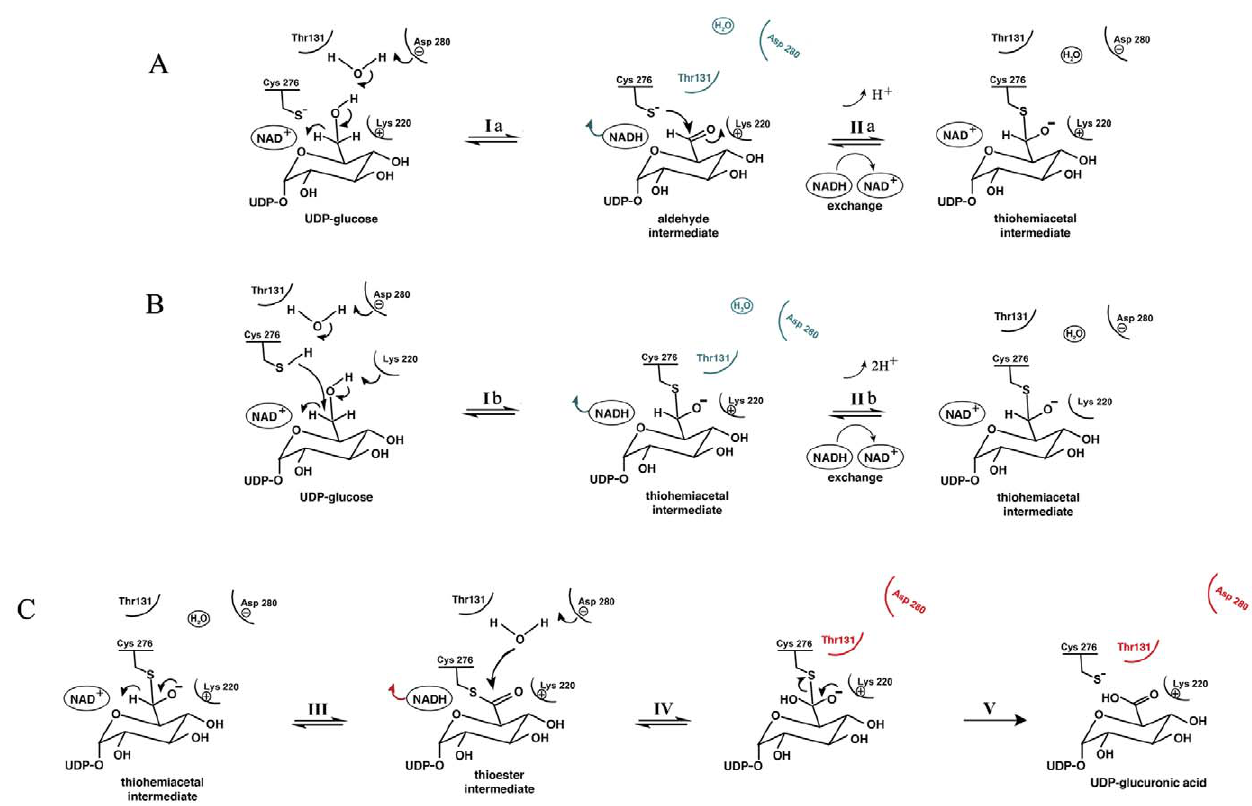
Figure 1. Mechanism of hUGDH catalysis. (A) In the first phase of the mechanism established from the structure of bacterial UGDH (Easley et al., 2007), a water molecule, activated by Asp280, is predicted to be the general acid/base catalyst that abstracts a proton from the C6 9 hydroxyl to initiate oxidation. Mutation of Asp280 to Asn is detrimental to catalysis. An aldehyde intermediate is transiently formed at the active site (Ia). This aldehyde has not been detected experimentally [14], however, added aldehyde functions as a substrate for the second oxidation [45]. The intermediate is then proposed to rapidly convert to the thiohemiacetal adduct (IIa), via Cys276, without being released and the second NAD + to replace the first reduced cofactor, NADH. (B) In an updated mechanism (Ib and IIb), the reaction proceeds directly to the thiohemiacetal adduct without proceeding through the aldehyde intermediate [28]. (C) In the second phase of both mechanisms, the thiohemiacetal is then oxidized to the thioester via transfer of hydrogen to NAD + (III). Finally the acid product is released through spontaneous hydrolysis [46,47]. Here the water bound to Asp280 is highlighted as the probable active water molecule. Evidence for a covalent thiohemiacetal (II) lies in the observation that the second deprotonation step (III) is reversible while the overall conversion to acid is irreversible (V) [38]. Mutation of Cys276 to serine led to the build up of covalently attached adduct, however, the C276A mutation, while not able to proceed to completion from UDP-glucose, was able to catalyze the oxidation of the aldehyde intermediate [45]. Lys220 provides charge stabilization to the anionic transition state during the second oxidation step (III), and for the course of the hydrolysis of the thioester (IV and V). Mutation of Lys220 significantly, but not completely, reduced the enzyme function suggesting that it does not form a Schiff’s base [34,48]. Features in blue and red indicate that Thr131 and Asp280 coordinate the movements of NAD + /NADH and the active water molecule.